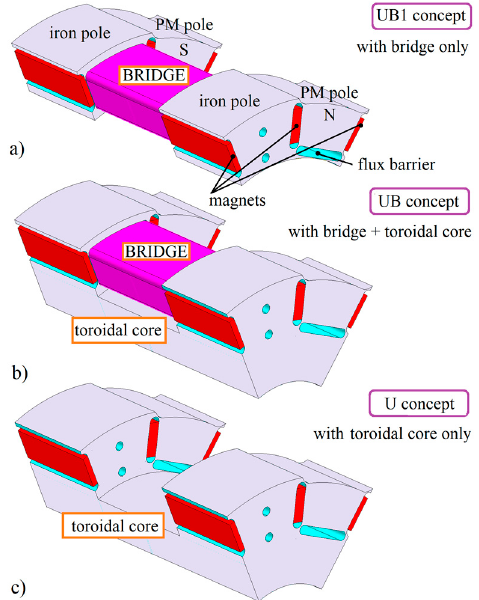
Figure 2. Three concepts of magnetic active parts of rotor of the electric controlled permanent magnet synchronous (ECPMS) machine: UB1 concept ( a ); UB concept ( b ); U concept ( c ).